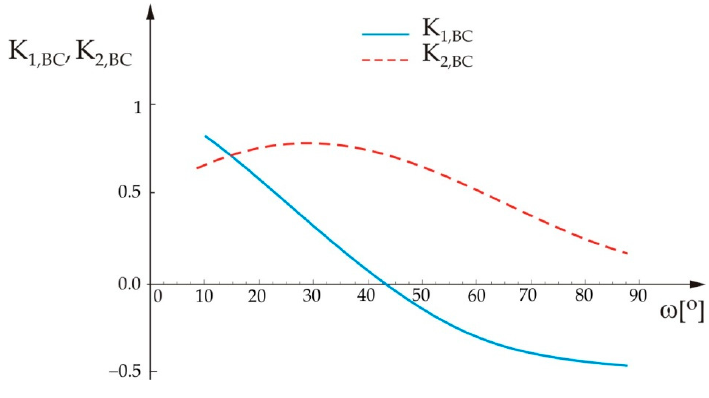
Figure 5. Variation of the real and imaginary parts of the stress intensity factors for the crack that deflects into the BC interface, in terms of angle ω .